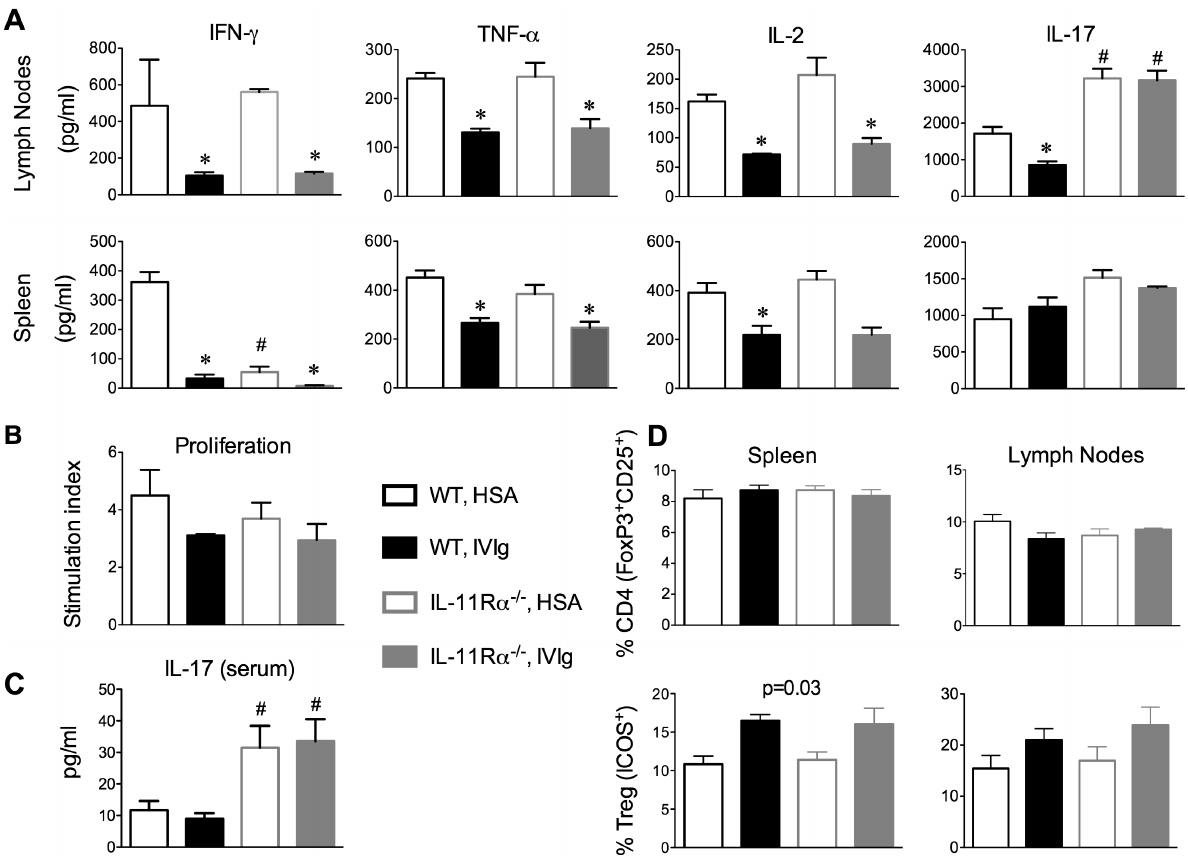
Figure 4. IVIg inhibits MOG 35–55 -induced pro-inflammatory cytokine production in IL-11R a 2 / 2 mice with the exception of IL-17A in the draining lymph nodes. IL-11R a + / + littermates (WT) and IL-11R a 2 / 2 mice were immunized with MOG 35–55 /CFA (no pertussis toxin), and were injected with either HSA or IVIg (1 g/kg, i.p.) daily. On day 6 ( D ) or on day 12 post-immunization ( A–C ), spleens and draining lymph nodes were collected, were processed into a single cell suspension, and were cultured with MOG 35–55 (5 m g/ml). A , The productions of IFN- c , TNF- a , IL-2 and IL- 17A were measured in supernatants of lymph node and splenocyte cultures of IVIg- or HSA-treated IL-11R a + / + (WT) and IL-11R a 2 / 2 mice. Values are means + SEM of triplicate cultures. These data are representative of three individual experiments. B , The proliferation in counts per minute (cpm) of spleen cells was measured using a [H 3 ]-thymidine incorporation assay. Shown is the stimulation index, which is the mean + SEM cpm in the MOG 35– 55 -stimulated wells divided by the cpm in the media control wells. Values are representative of means + SEM of individual mice (N=4–5/group) in one representative experiment. C , Sera was taken from mice at 12 days post-immunization and the levels of IL-17 were measured using FlowCytomix assays. Values are means + SEM of individual mice (N=4–5/group). D , Lymph node and spleen mononuclear cells taken at day 6 post-immunization (peak of ICOS expression) were stained for CD4, CD25, FoxP3, and ICOS. The frequency of Tregs was determined, as was the frequency of these cells that were ICOS positive. Values are means + SEM of N=3 individual mice per group. In all cases, groups were compared using a one-way ANOVA and Tukey post-hoc test. *p , 0.05 indicates a difference of the IVig group from the HSA-treated, genotype-matched counterpart. # indicates a significant difference of the IL-11R a 2 / 2 group from the IL-11R a + / + , treatment matched counterpart.